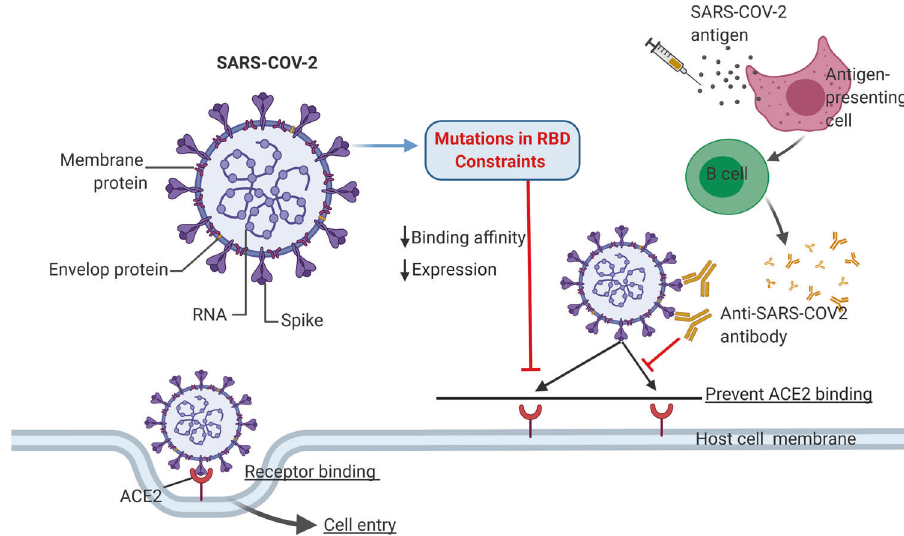
Fig. 1 Prevention of SARS-Cov-2 viral-escape by targeting RBD constraints. The fi gure is created by